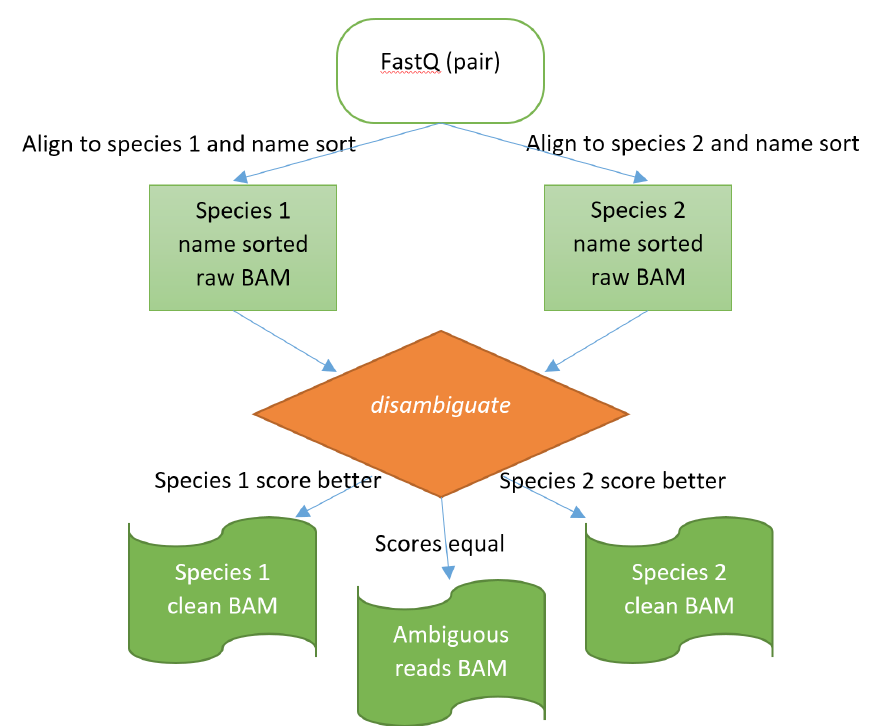
Figure 1. The disambiguation process illustrated. Alignment is first performed against both species. The disambiguation application then operates on the raw, natural name sorted BAM files to assign the read pairs into one of the two species or as ambiguous for unresolved